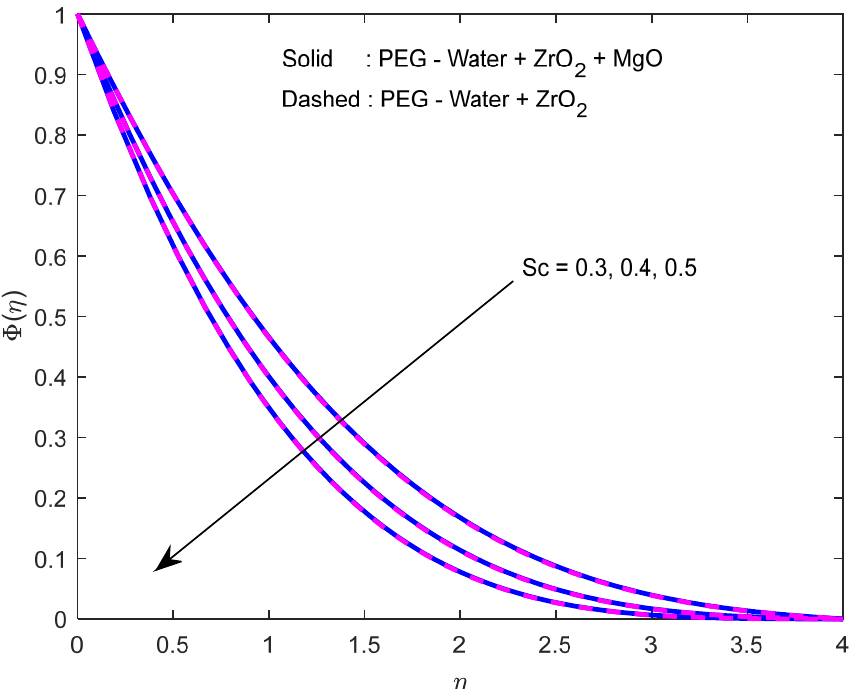
Figure 14. Effects on concentration due to Kr .